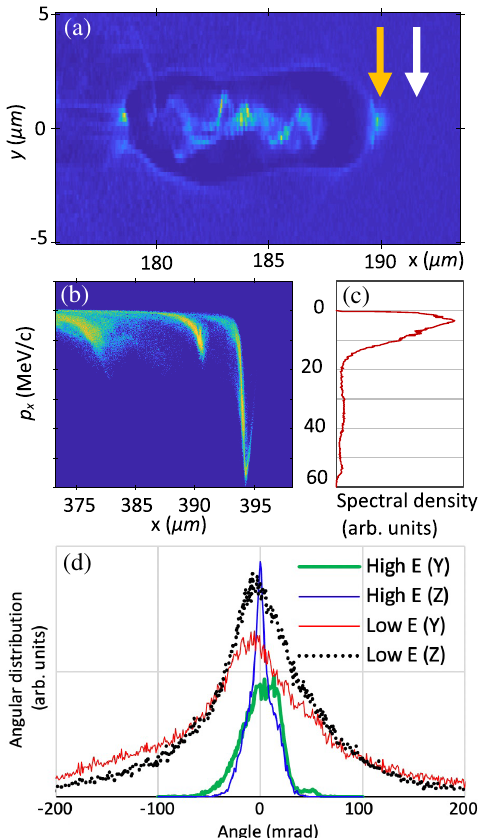
FIG. 9. (a) Plasma density profile snapshot after transition to a beam-driven wake, with the orange arrow showing the position of the driving electron bunch, and the white one showing the position of the laser pulse. (b) longitudinal phase-space plot of the electrons and (c) corresponding spectrum. (d) Angular distribu- tion of the high- and low-energy electron population in both transverse